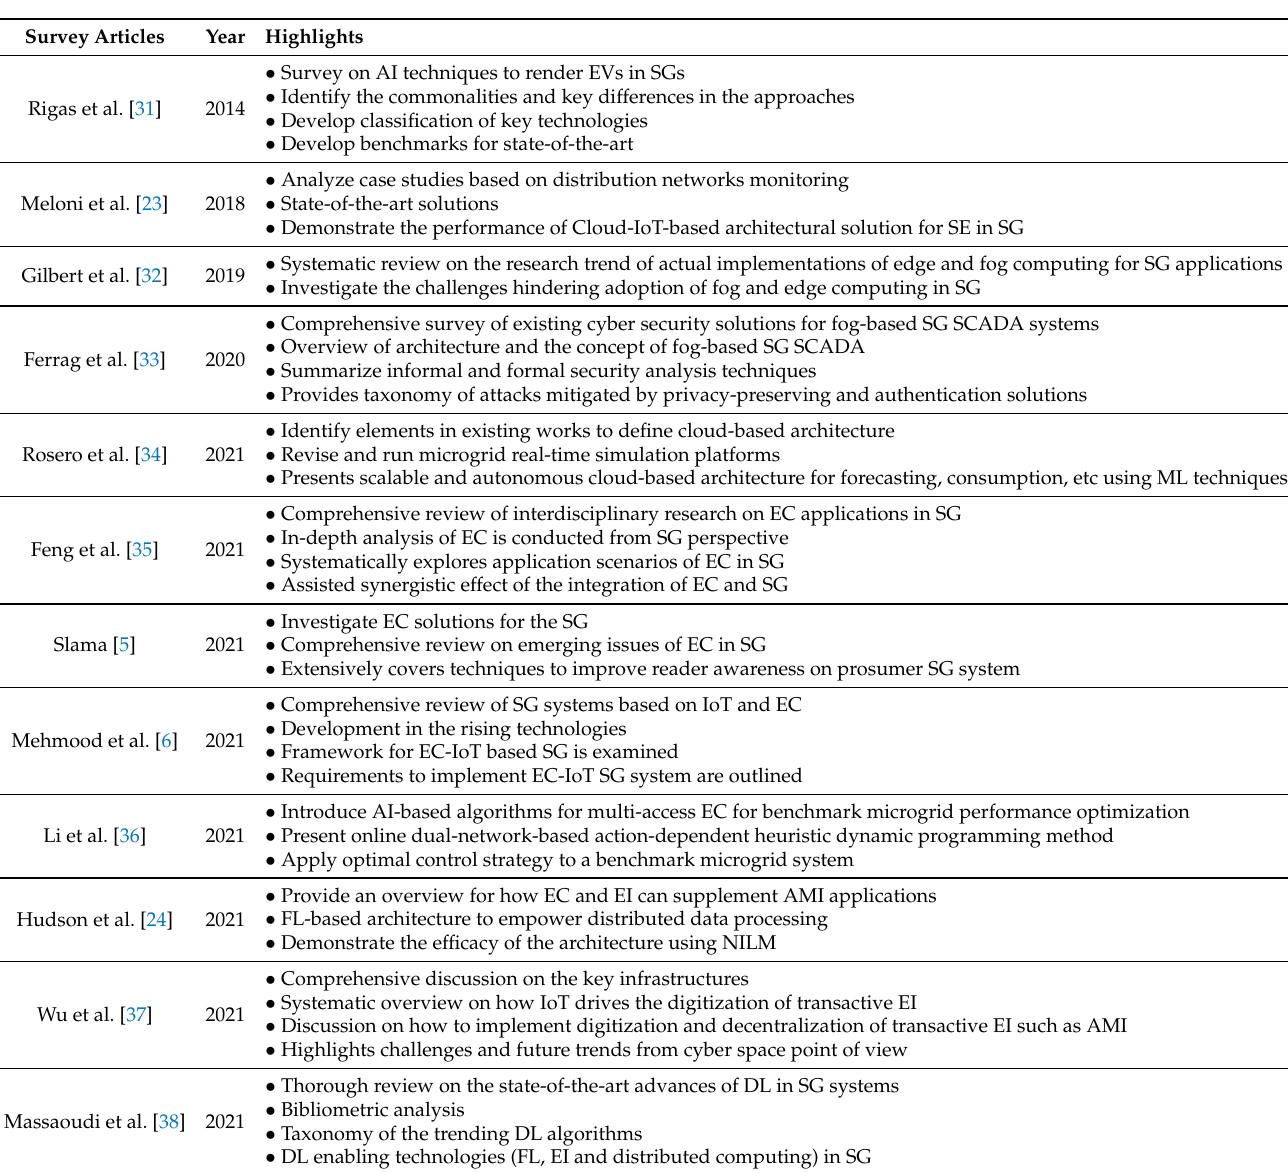
Table 1. Summary of Related